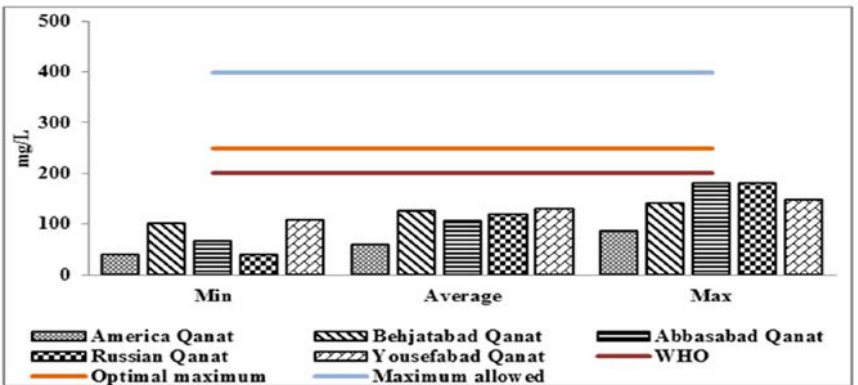
Fig. 7: Sulfate level and its comparison with the WHO and the National Standard of Iran